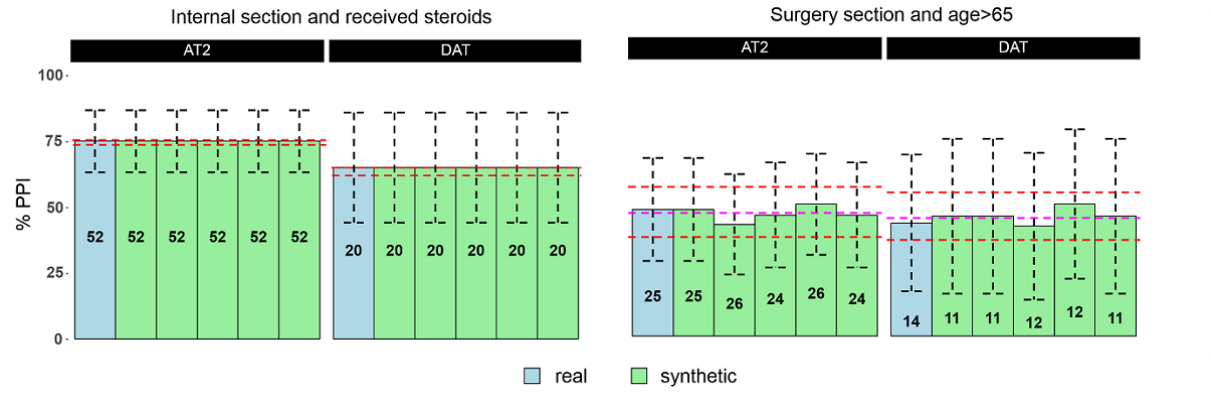
Figure 1. PPI administration (%) for patients receiving the clopidogrel, prasugrel or ticagrelor antiplatelet (AT2) or dual antiplatelet (DAT). The total number of patients in the subgroups are given inside the bars. If no censoring was required (left panel – Internal Section patients that received steroids), proportions of PPI administration calculated from the synthetic sets were essentially identical to the proportions in the real data, and their range across 1000 sets (minimum and maximum in red dotted lines) was very narrow. If censoring was required, as in the case of the Surgery Section, results varied across the synthetic sets, and their ranges were wider (right panel – Surgery Section patients older than 65 years). The means across 1000 sets (purple lines) show small